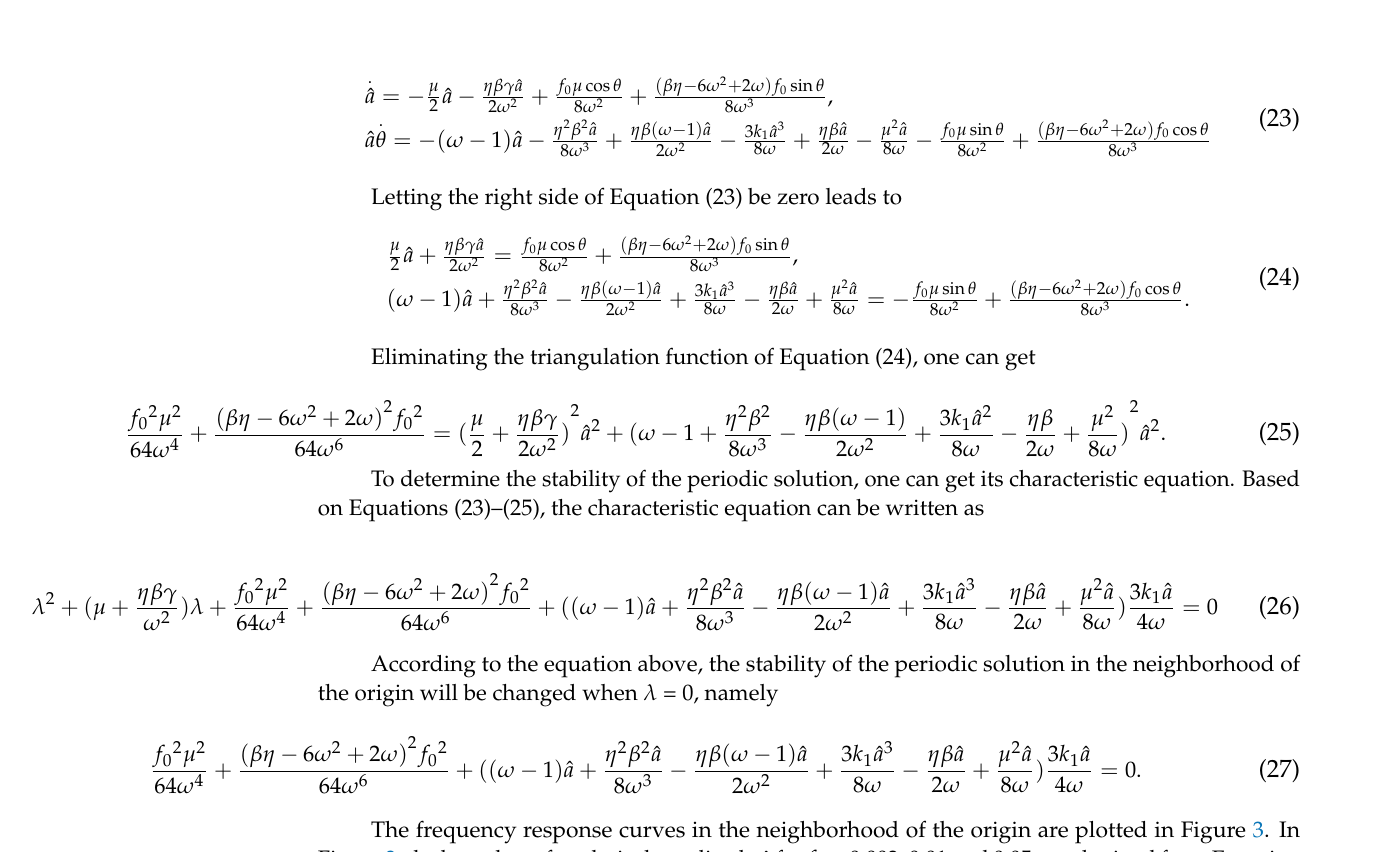
Figure 3, the branches of analytical amplitude ˆ a for f 0 = 0.002, 0.01 and 0.05 are obtained from Equation (25). The solid curves and the dashing ones represent the stable and unstable periodic solutions, respectively. Their stability is determined by the positive-negative sign of the real parts of eigenvalues solved from Equation (26). Based on Equation (27), one gets the saddle-node point separating the solid curve and dashing curve. The numerical results for the amplitudes of periodic responses are presented by applying the 4th Runge-Kutta approach to simulate the numerical solutions of the dimensionless system (5) via MATLAB. Definitely, the numerical approach will only produce stable solutions. As illustrated in Figure 3, there is a good agreement between the theoretical and numerical response results, implying the approximate-analytical solutions are valid. Furthermore, it follows from Figure 3 that for f 0 = 0.05 and ω in the range (0.50, 0.76), the frequency response curves bend to the left and yield multivalued solutions. It means that the saddle-node bifurcation of the periodic solution around the origin O(0, 0), hence the coexistence of two intra-well attractors, can be triggered by the increase of f 0 and the variation of ω in a low-frequency range.